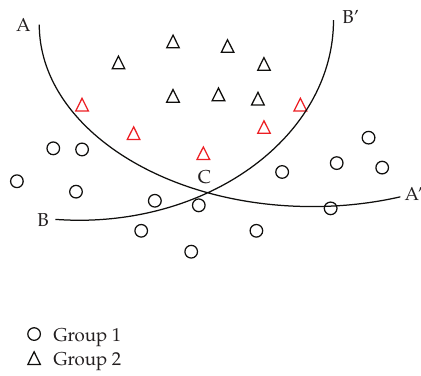
Figure 3: A two-group discriminant